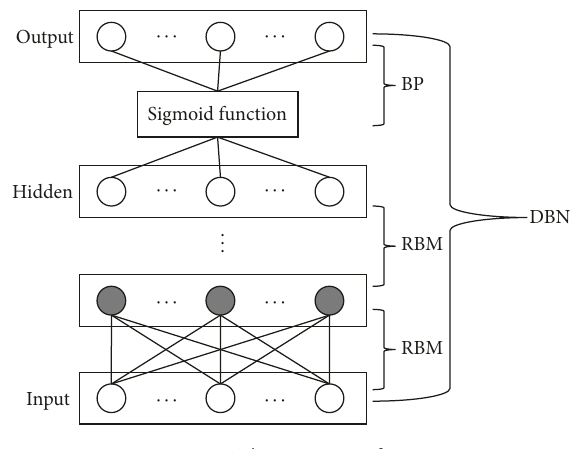
Figure 3: The structure of